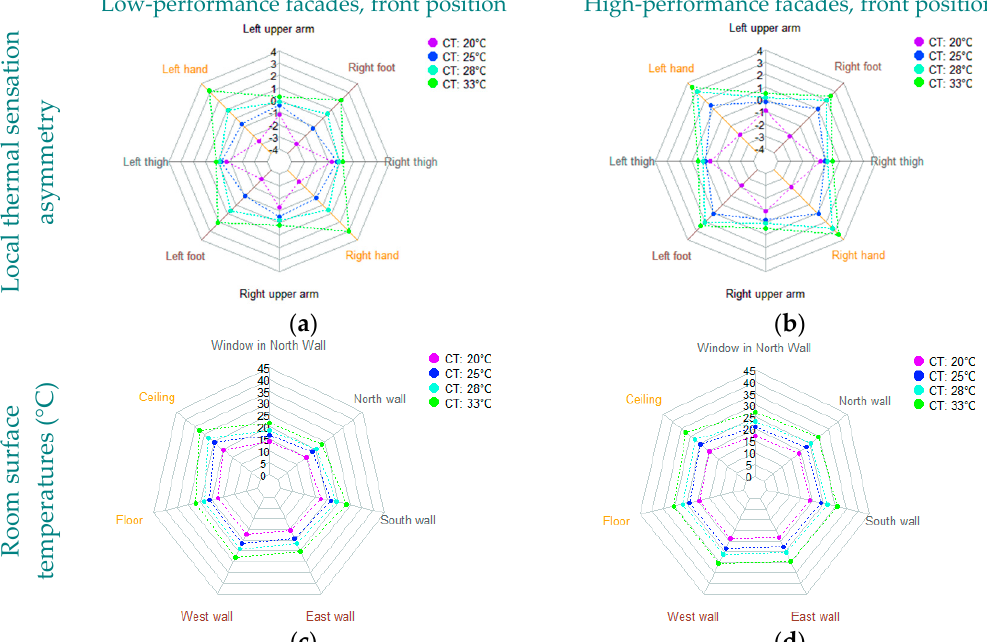
Figure 19. Local thermal sensation asymmetry between right and left sides of selected pairs of the body parts ( a , b ) and room surfaces’ temperatures ( c , d ) corresponding to four ceiling temperatures and the qualities of two façades in the corner room.